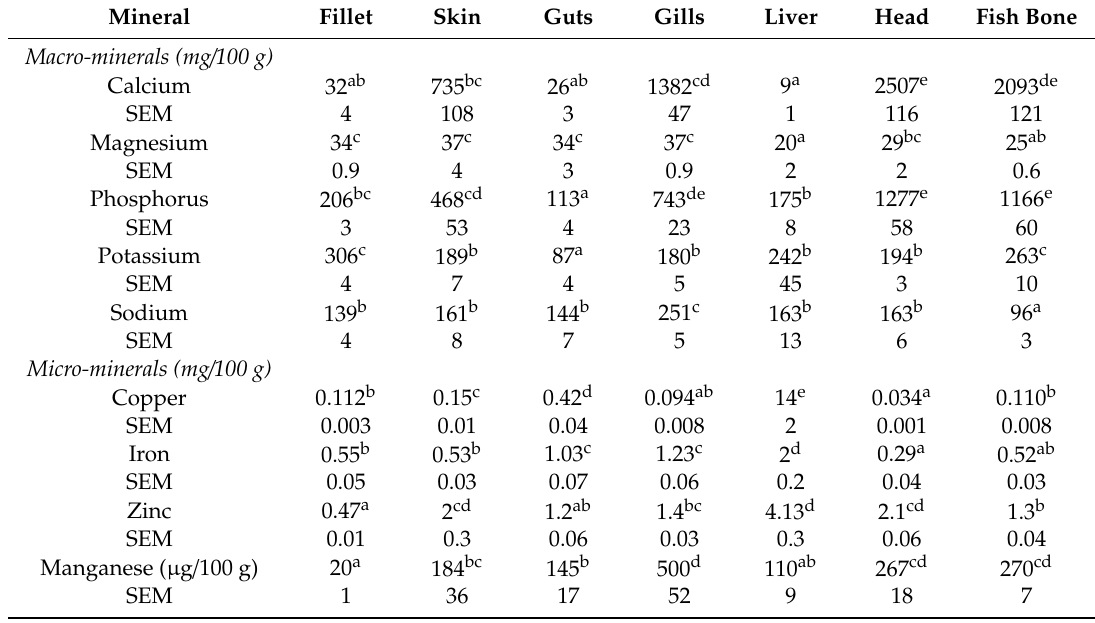
Table 5. Mineral profile of sea bass fillet and by-products. Mineral Fillet Macro-minerals (mg / 100